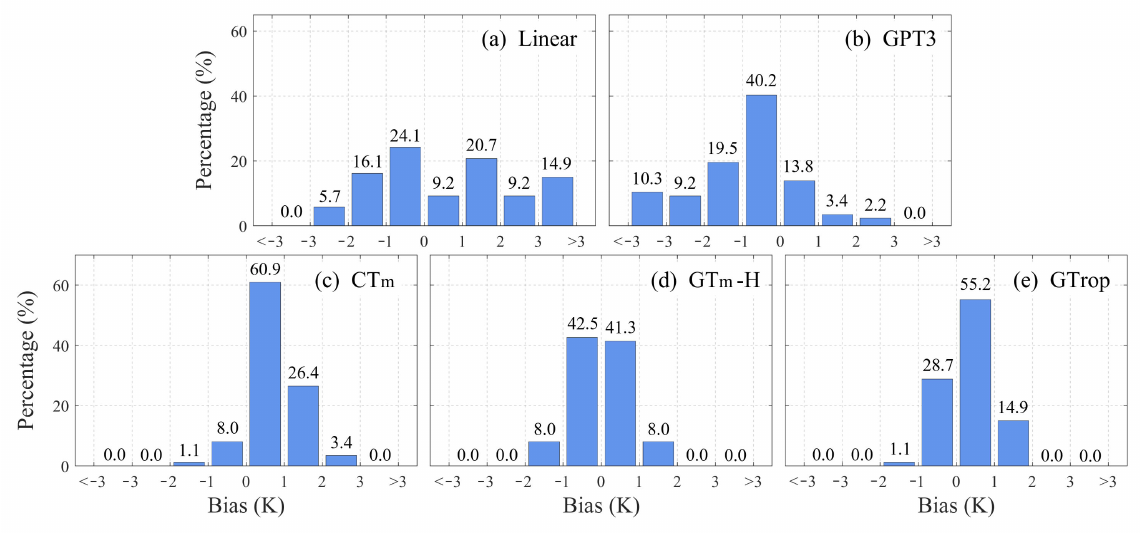
Figure 11. Percentage of Bias in different intervals calculated by the five T m models at 87 RS stations over the period of 2011 to